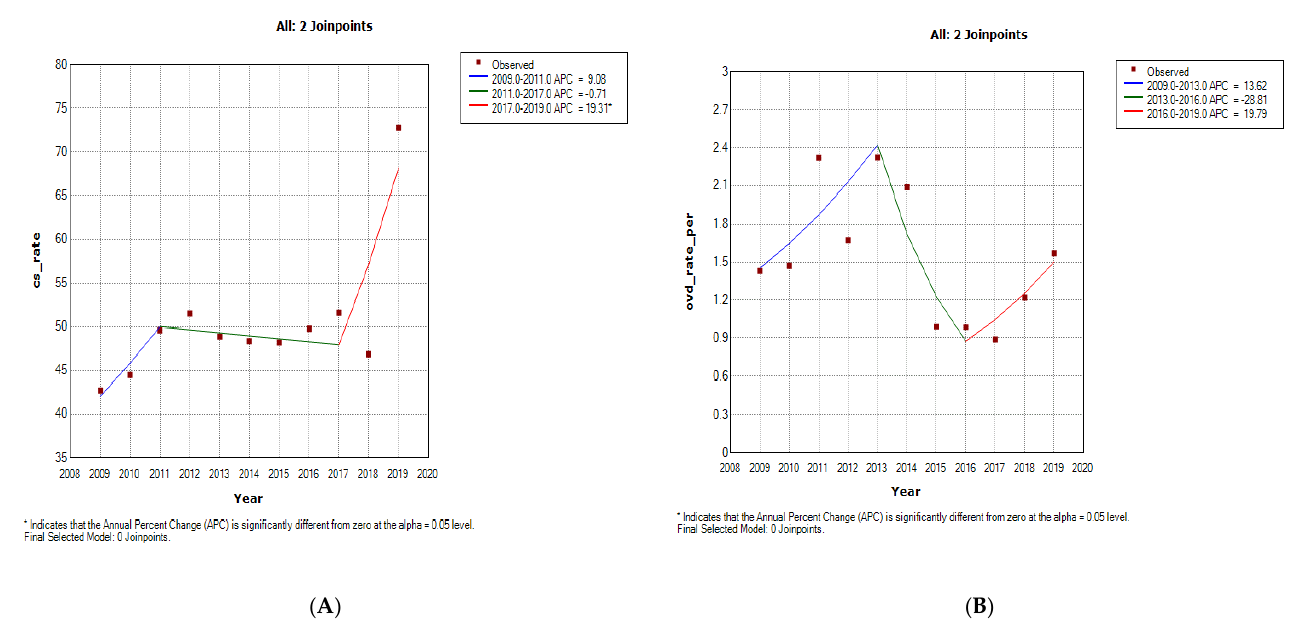
Figure 3. Join point regression analysis of the trends in caesarean section ( A ) and operative vaginal delivery ( B ) rates at Charlotte Maxeke Johannesburg Academic Hospital (2009 – 2019).